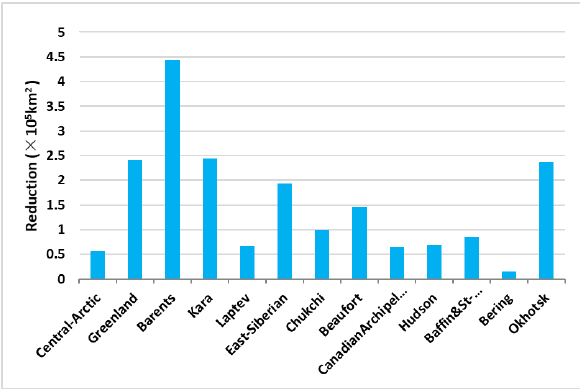
Figure 5. The total reduction of sea ice extent of 13 regions in Arctic from 1979 to 2016 Besides the annual melting rate, the standard deviation of sea ice extent in each region is also be considered, which can indicate the divergence between the data of sea ice extent and the trend line fitted by equation (1). The melting rate and corresponding standard deviation of 13 regions in Arctic during both melting period (spring and summer) and freezing period (autumn and winter) are shown in Figure 6. It is found that the sea ice in Barents, Greenland, Okhotsk and Baffin & St- Lawrence is more active than other regions. Figure 3. Monthly change trend of sea ice extent in Arctic from 1979 to 2016 In order to analysis the change characteristics of sea ice extent in Arctic in detail, the Arctic is divided into 13 regions according to (Xia et al., 2014; Fetterer et al.,2017), as shown in Figure 4. The total reduction of Arctic sea ice in 13 regions from 1979 to 2016 is presented in Figure 5.